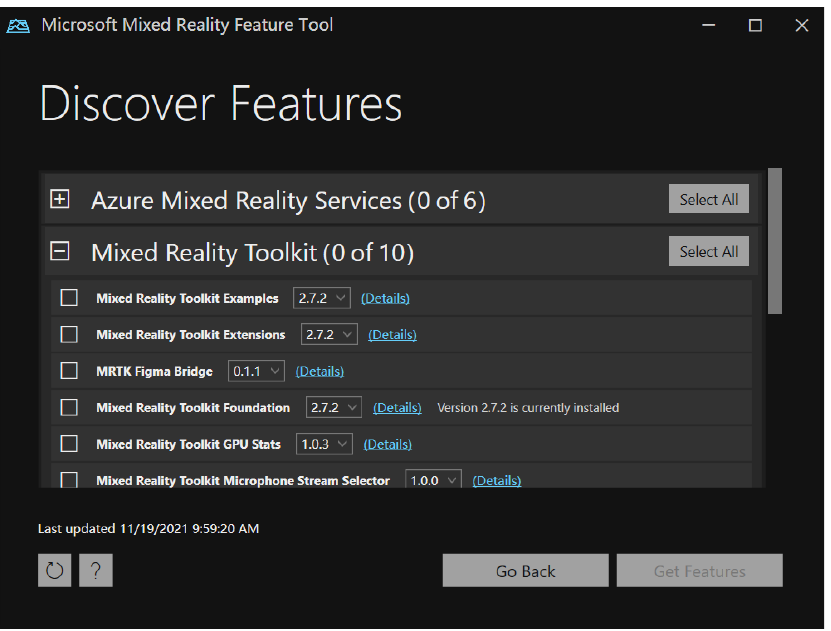
Figure 12. Mixed Reality Toolkit.